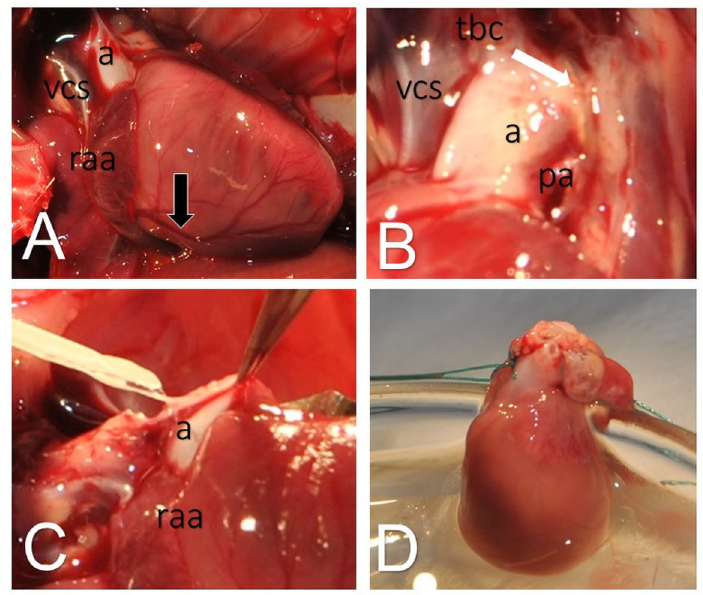
Fig 4. Technical considerations for heterotopic heart transplantation in Lewis rats with prior transverse aortic constriction. Exposition of hypertrophic heart three weeks after transverse aortic constriction with right coronary artery (black marker), aorta (a), superior vena cava (vcs) and right atrial appendage (raa) (A). View from anterior with aorta (a), clip (white marker) and adhesions of aorta, pulmonal artery (pa), superior vena cava (vcs) and brachiocephalic trunc (tbc) (B). Cardioplegia has to be administered rapidly (C) via a 22 Gauge (0.9 mm) canula leading to collapse of heart function and fading of coronary arteries